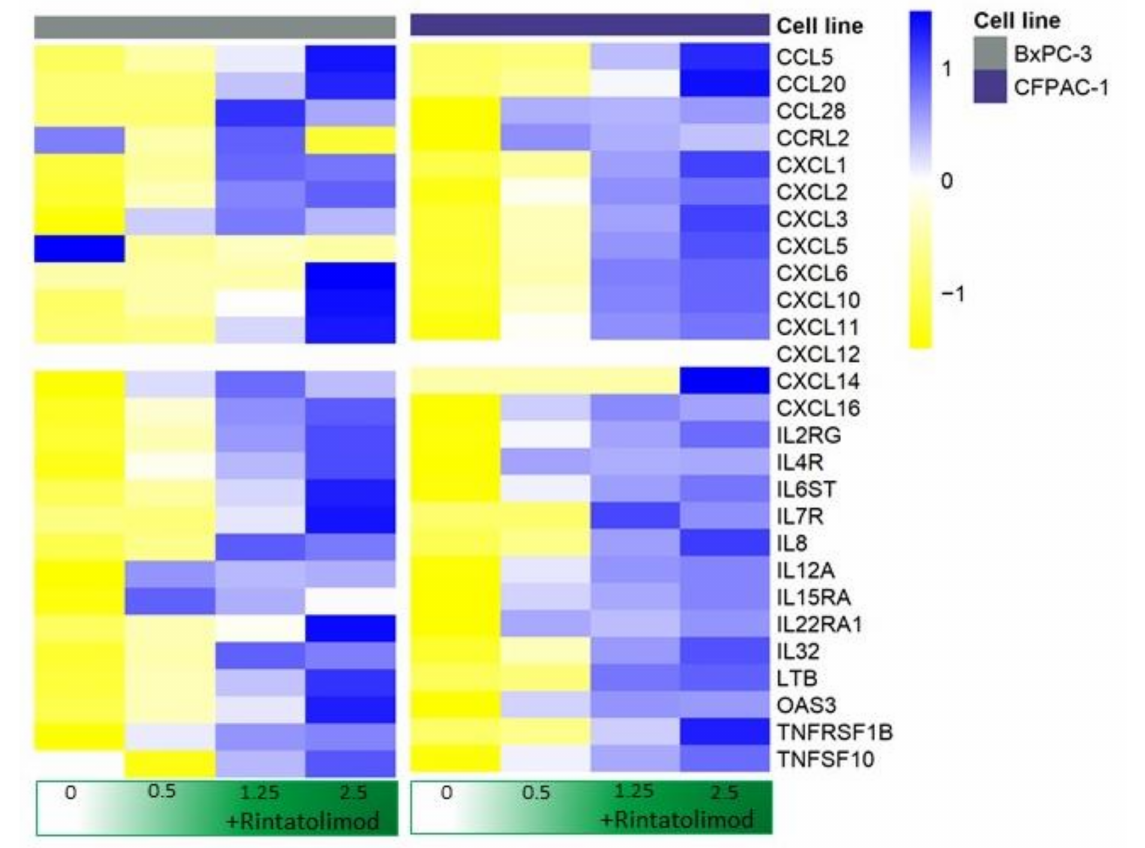
Figure 2. Rintatolimod produced immunomodulatory activity in HPAC cells. Heat maps of cytokines and interleukins that were differentially regulated as an effect of Rintatolimod. The expressions were gene-wise scaled and are displayed as colors ranging from blue (high expression) to yellow (low expression) as shown in the key. Cells were treated with various concentrations of Rintatolimod displayed as the intensity of green color from dark green (high dose) to white (PBS control).